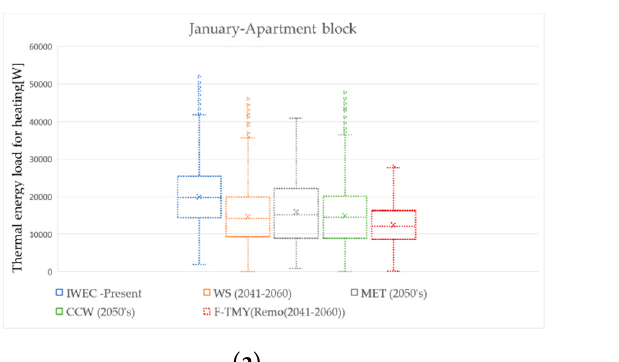
Figure 5. Boxplots of heating loads in January ( a ) and cooling load in August ( b ) of the apartment block for IWEC (Present), Weathershift (WS), Meteonorm (MET), CCWorldWeatehr-Gen (CCW), and F-TMY. All future weather files are for 2050s considering RCP 8.5.